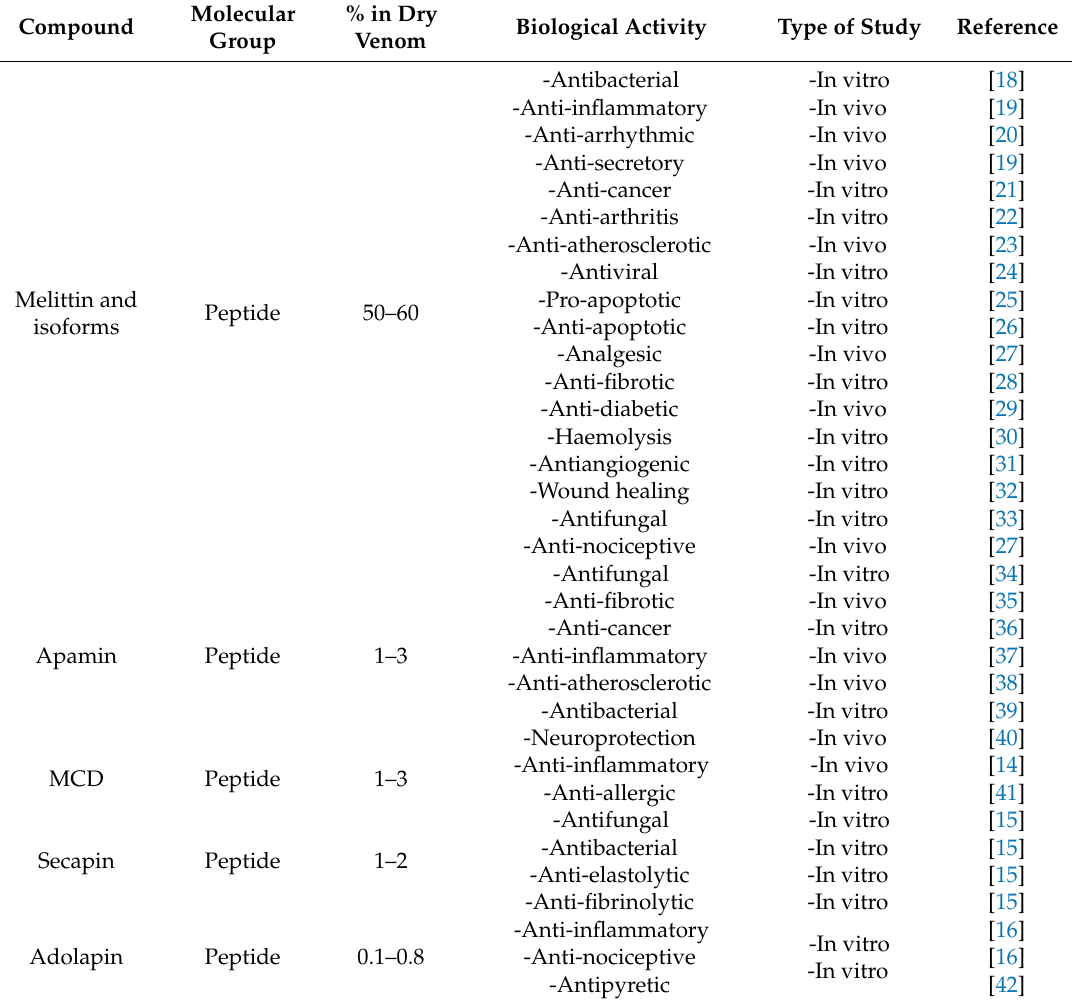
Table 1. Major components of bee venom (BV) related to their abundance, biological activity and type of study carried